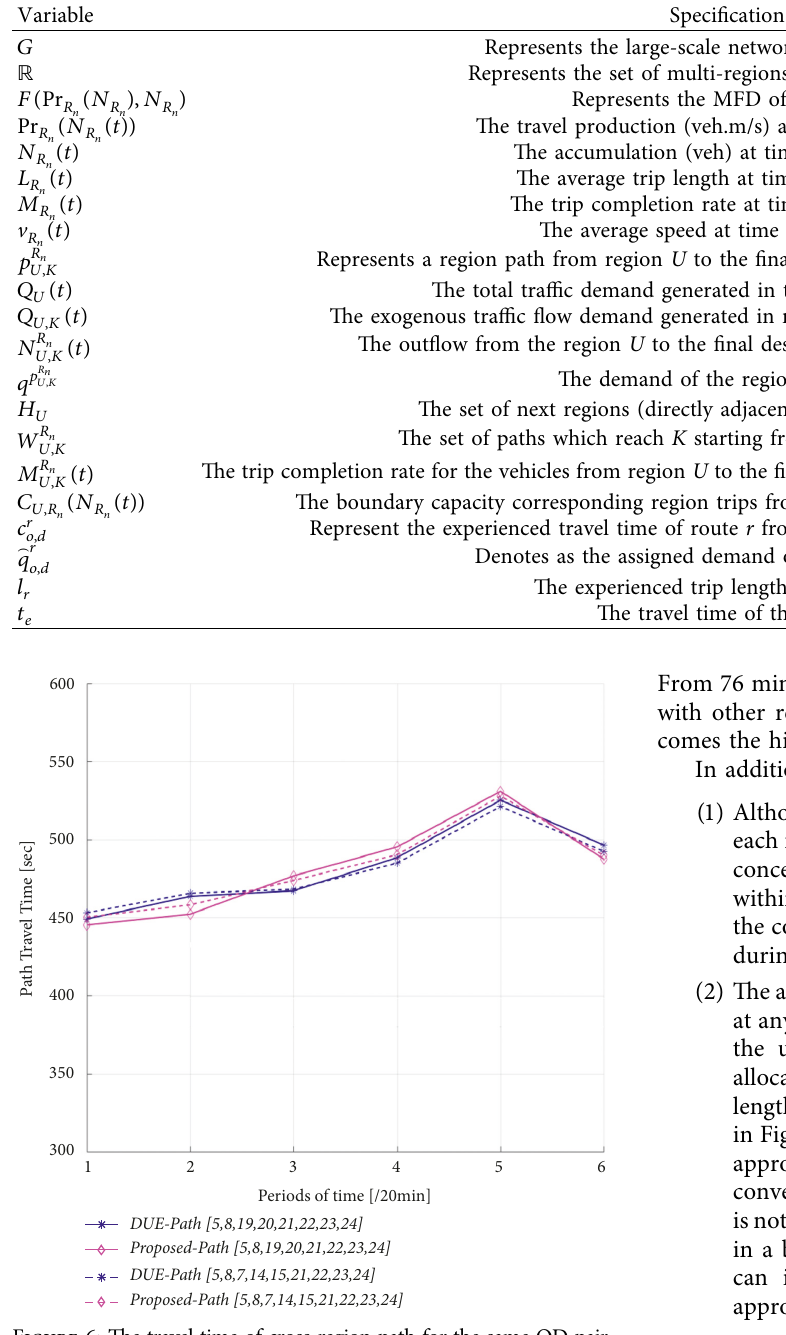
Figure 6: The travel time of cross-region path for the same OD pair.